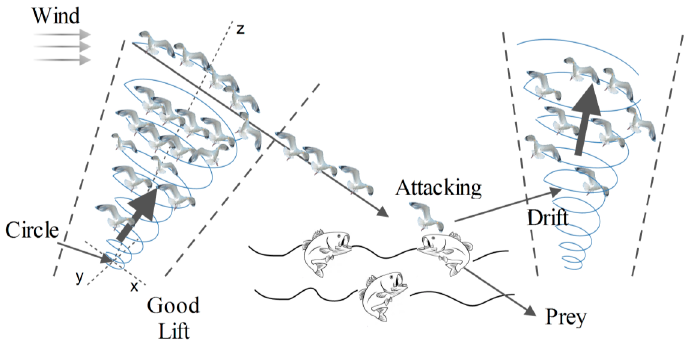
Figure 3. Migration and attacking behaviors of seagulls.